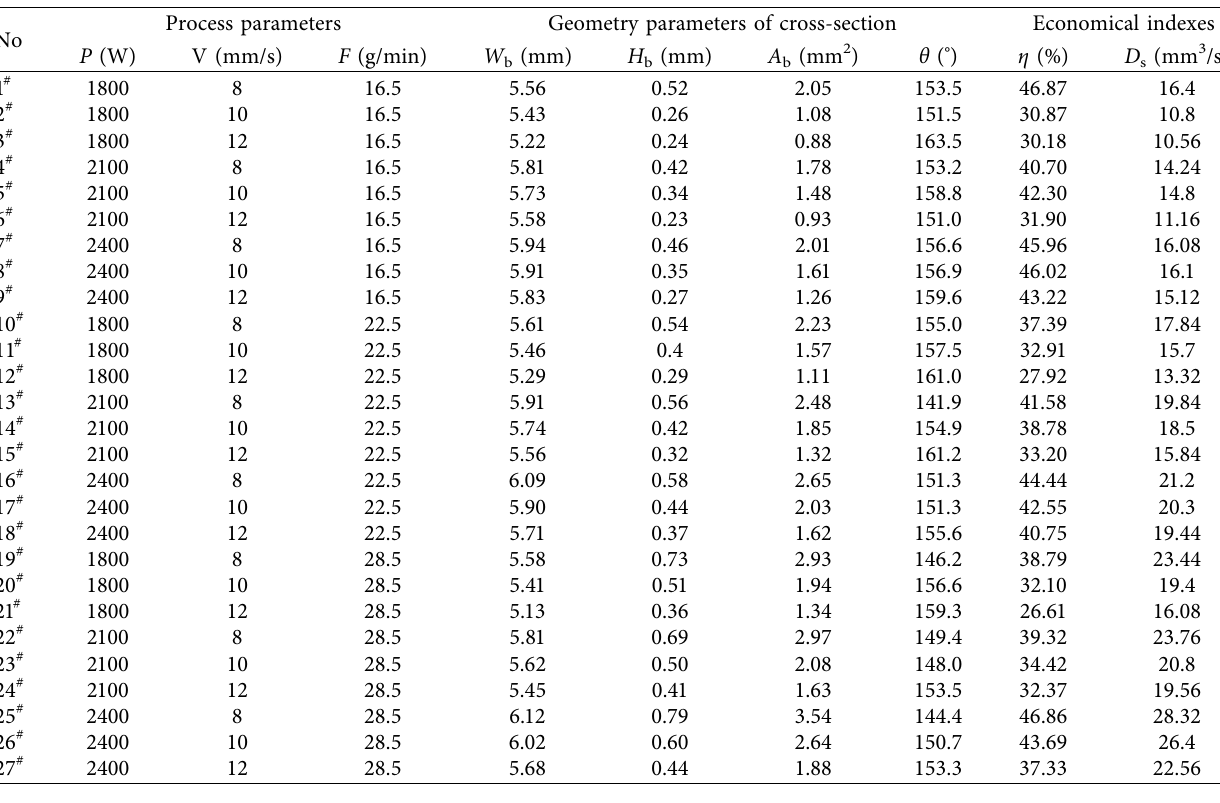
Table 2: Geometry parameters, corresponding powder efciency ( η ), and deposition speed ( D parameters.